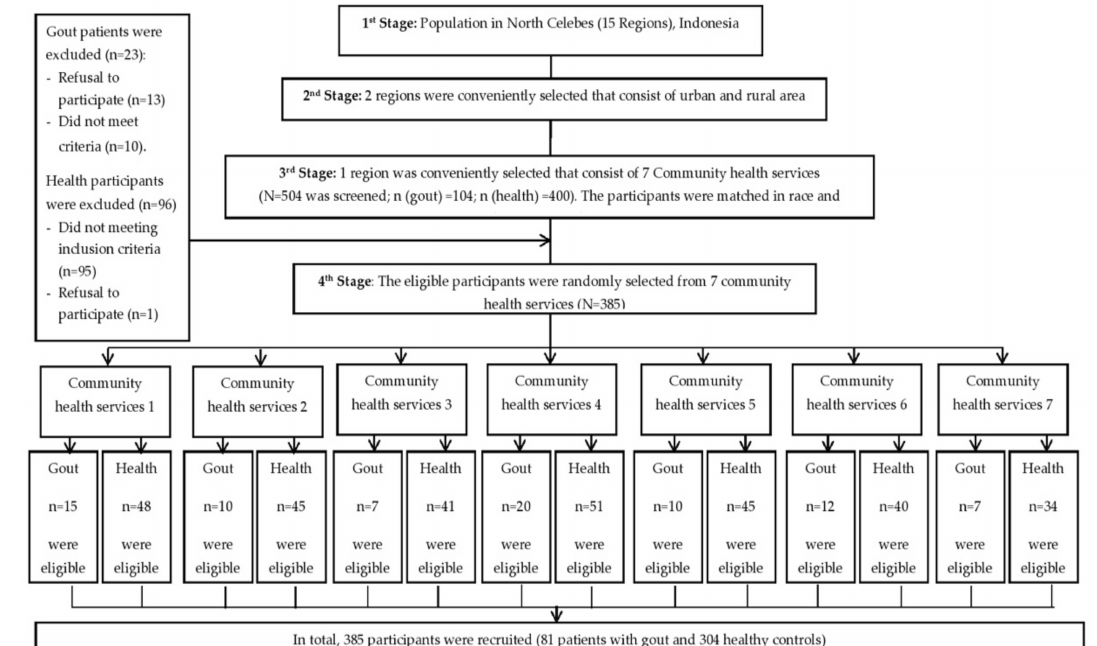
Figure 1. Participants Recruitment Flow